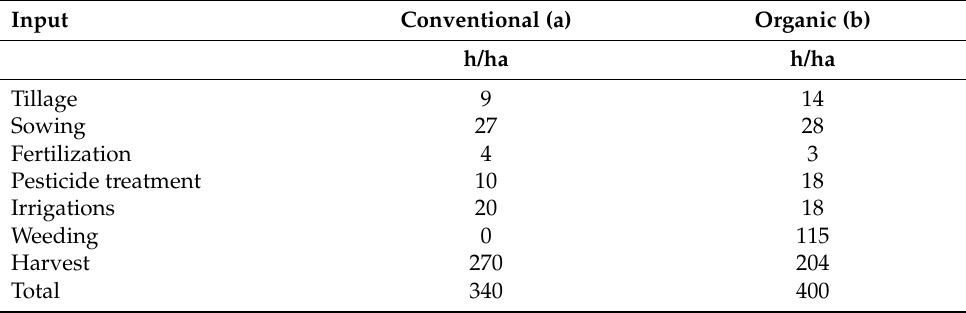
Table 6. The activity level of early potato growing (*).